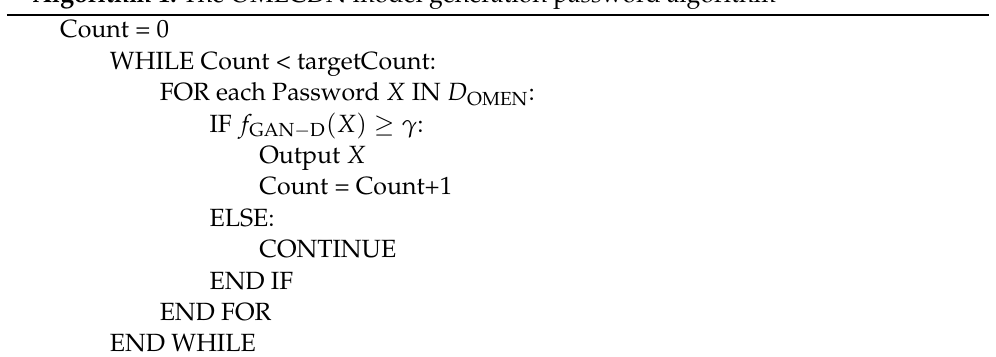
Algorithm 1: The OMECDN model generation password